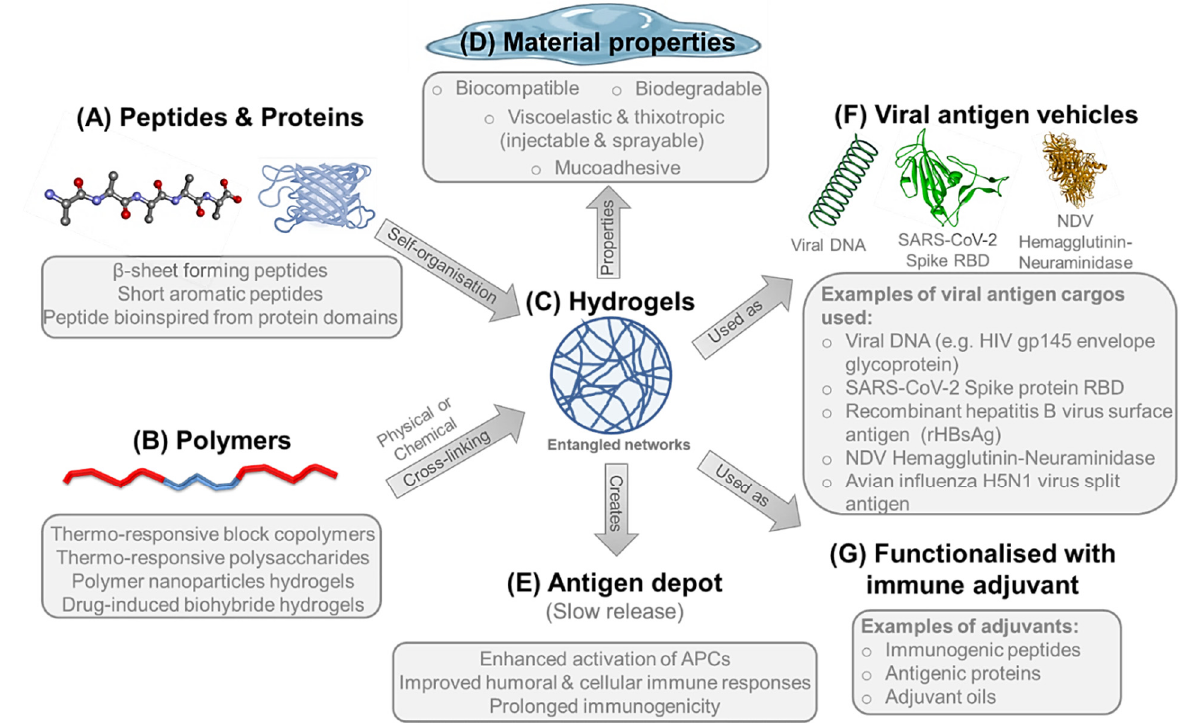
Figure 4. Hydrogels are formed either by the ( A ) self-organisation of peptides or proteins or ( B ) physical or chemical cross-linking of polymers to form ( C ) entangled networks of nanofibrous structures in aqueous matrix, which is ( D ) self-supportive viscoelastic and thixotropic materials that can be injected and sprayed for clinical administration of vaccine formulations. Where natural or bioinspired building blocks are used to create the hydrogel network, the material becomes biocompatible and biodegradable implying low toxicity. Hydrogels are mucoadhesive, so can create localised ( E ) viral antigen depot postinjection/spraying, providing slow and controlled release of antigenic cargo leading to enhanced activation of APCs, improving both humoral and cellular immune responses over a prolonged period. Hydrogels have been used as ( F ) vehicles for various viral antigens and ( G ) could be functionalised with immune adjuvants as stimulatory agents to potentiate the immune response towards the delivered viral